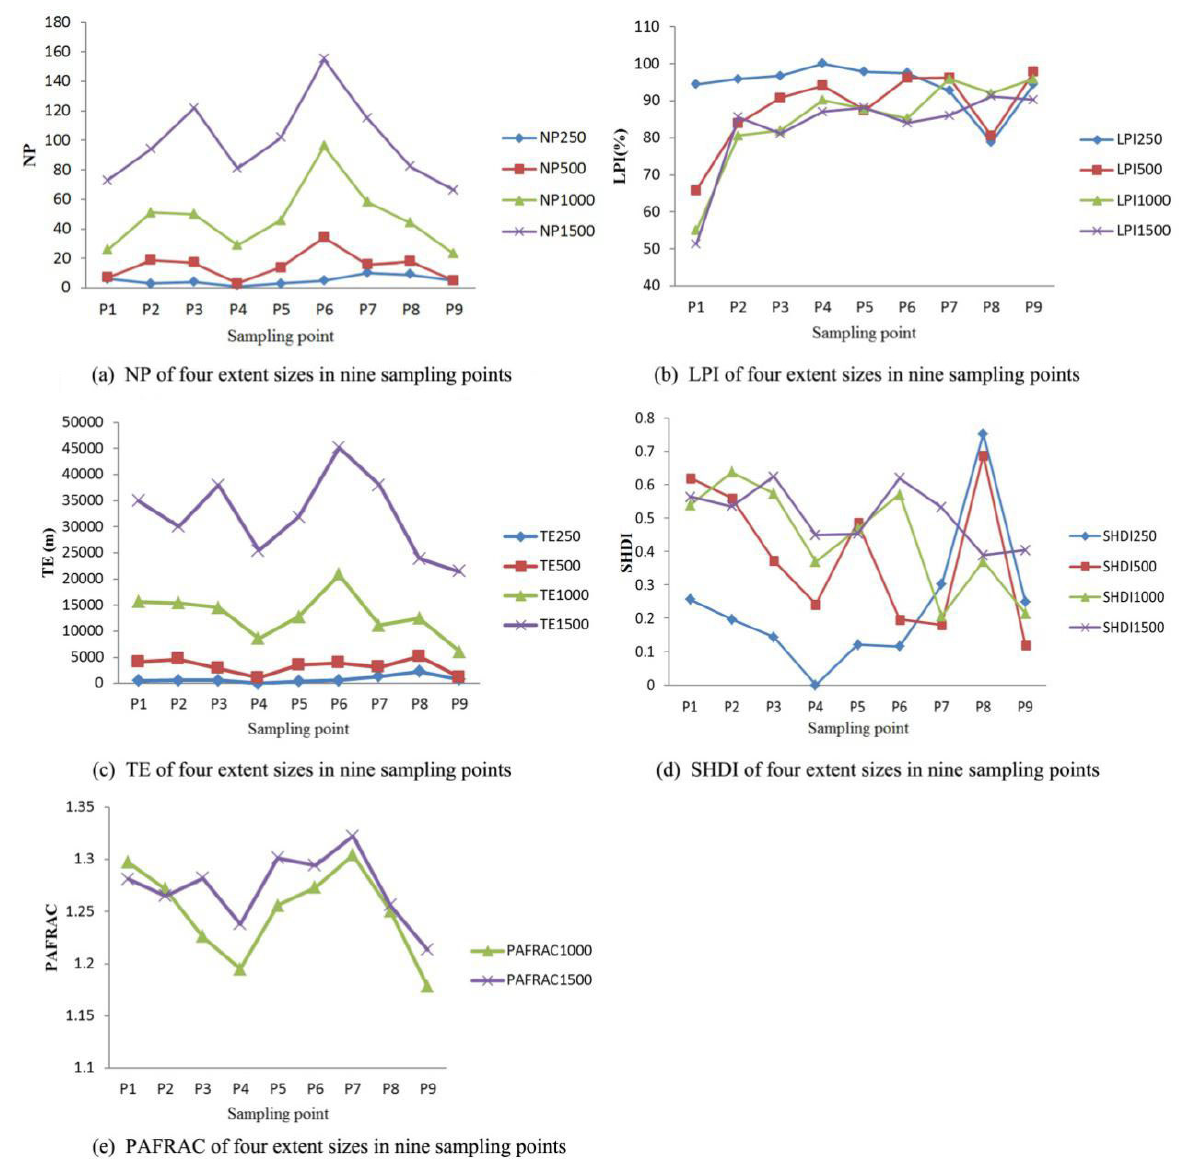
Figure 4. The landscape pattern metrics of four extent sizes in sampling